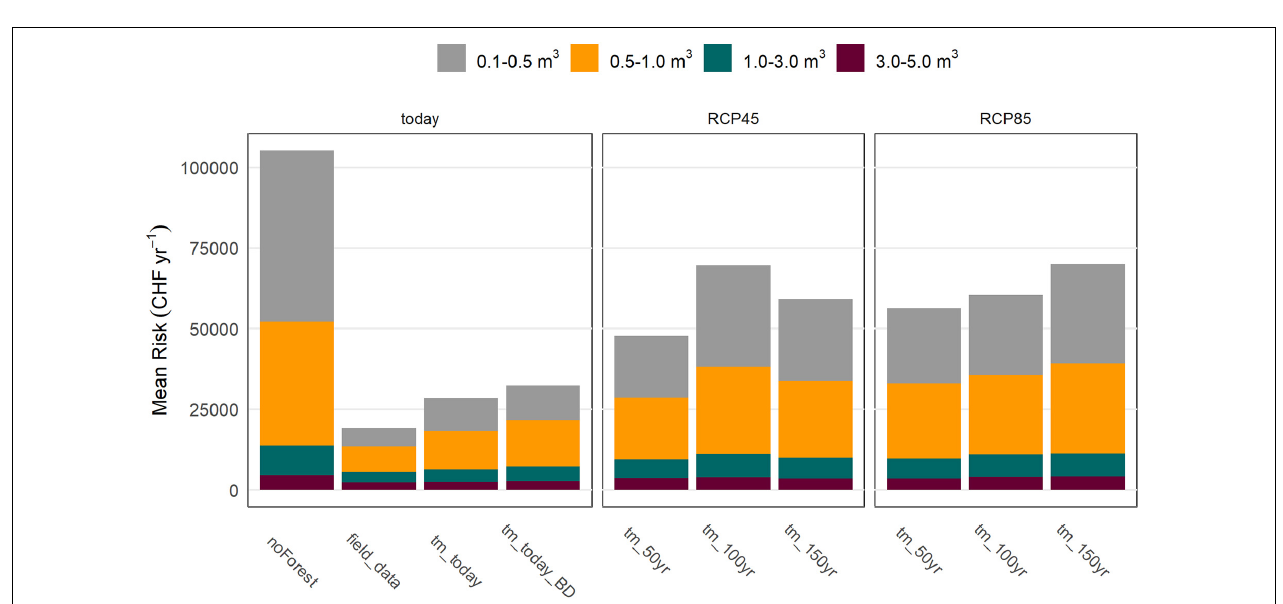
FIGURE 9 | Simulated mean density and standard deviation of the regeneration of the main species under the future climate scenarios RCP4.5 ( above ) and RCP8.5 ( below ) in 50 years and for high background disturbance (“future_Dist”; red) and low background disturbance (“future_noDist”; blue).